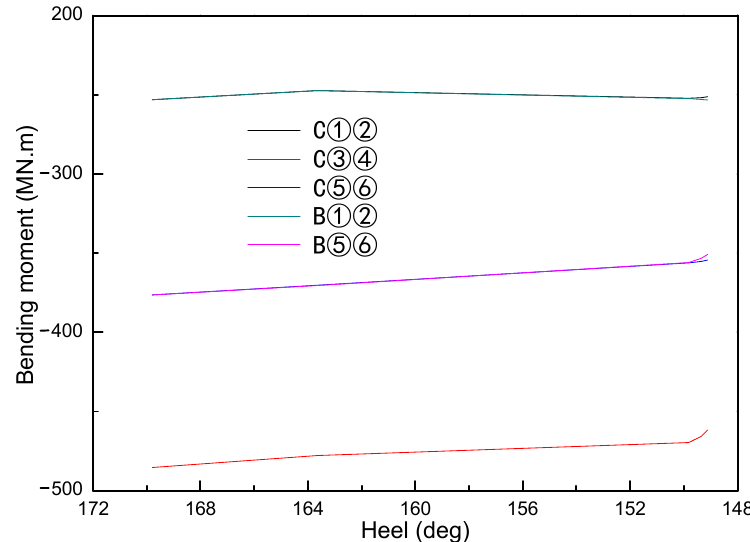
Figure 7. Variation of bending moment under case Ⅰ .